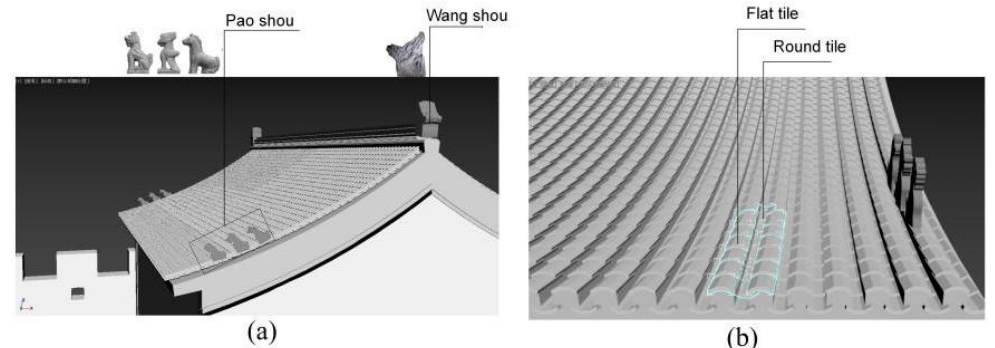
Figure 10. The virtual restoration of roof and decorative elements.